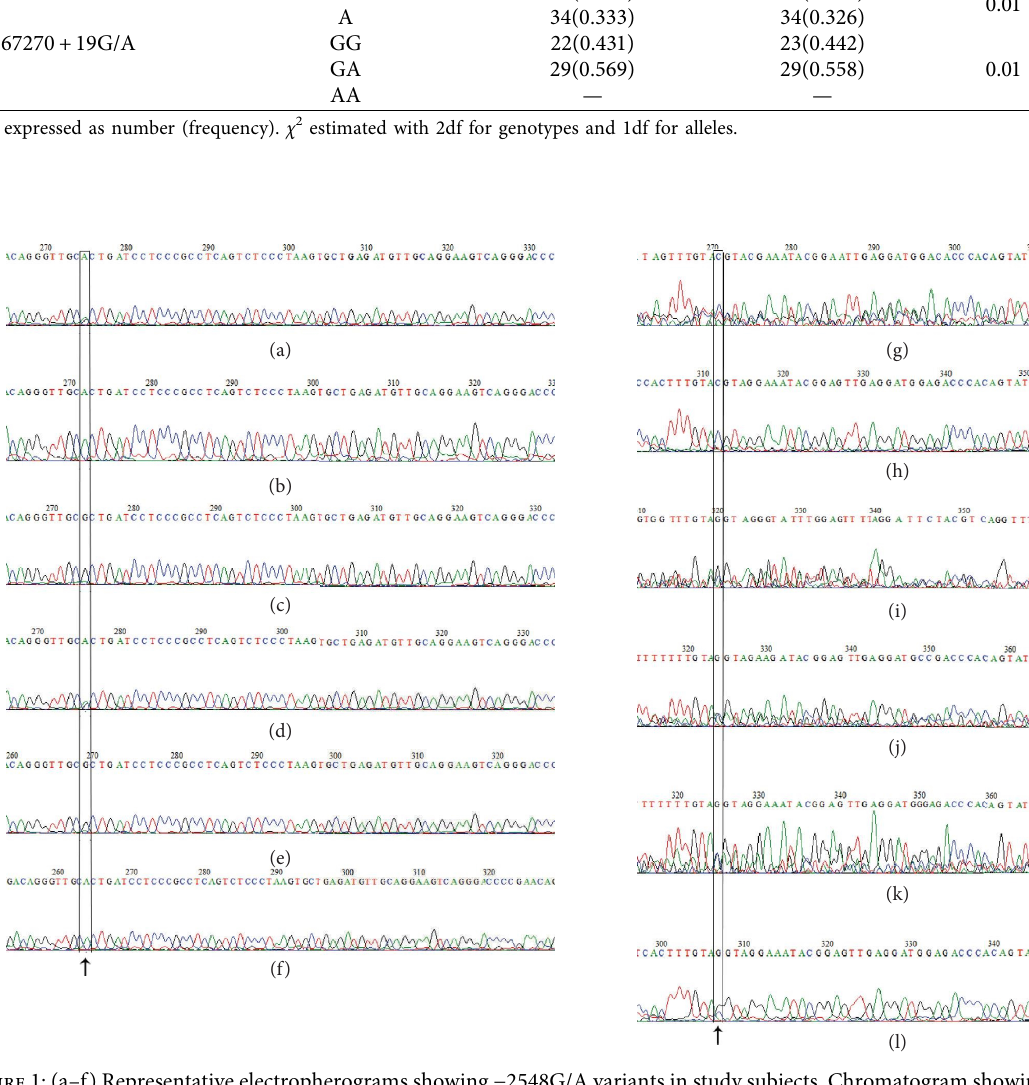
Figure 1: (a–f) Representative electropherograms showing − 2548G/A variants in study subjects. Chromatogram showing (a) heterogenous variant (AG) in control (ID: C058); (b) homozygous variant (AA) in control (ID: C299); (c) homozygous variant (GG) in control (ID: C201); (d) heterogenous variant (AG) in case (ID: P080); (e) homozygous (AA) variant in case (ID: P151); (f) homozygous (GG) variant in case (ID: P116). Variant alleles marked. (g–l) Representative electropherogram showing LEP rs570757178(C/G) variants in study. (g) Homozygous (CC) in case (P293); (h) homozygous (CC) in control (C020); (i) heterozygous variant (CG) in case (P291); (j) heterozygous variant (CG) in case (P288); (k) heterozygous variant (CG) in overweight (C063); (l) heterozygous variant (CG) in subject with overweight (C155).